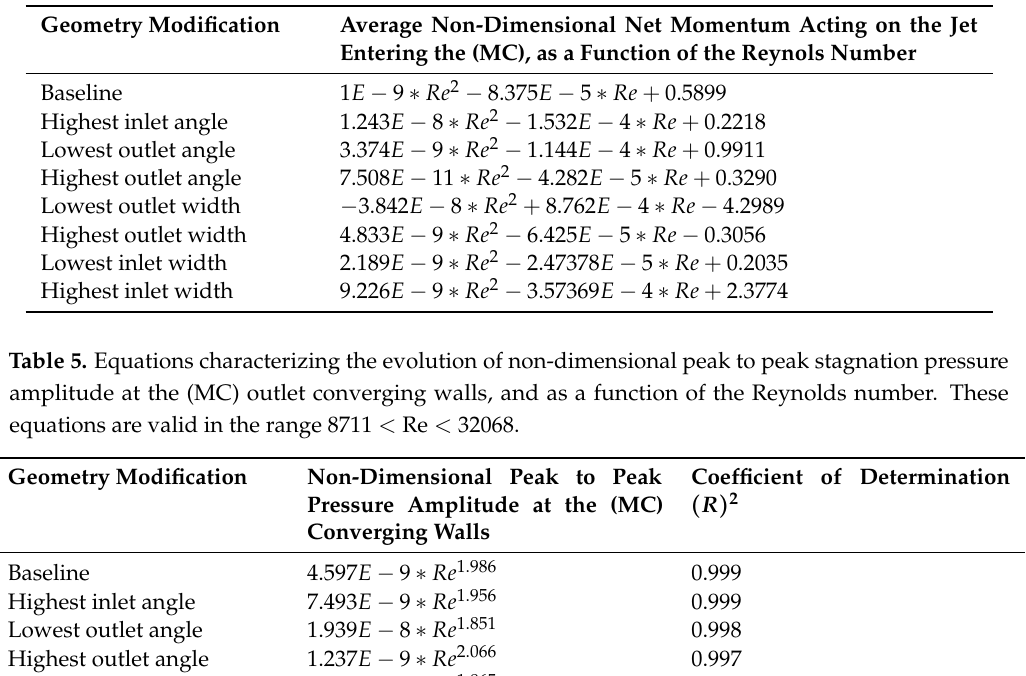
Table 4. Equations characterizing the evolution of non-dimensional average net momentum acting on the jet entering the (MC), and as a function of the Reynolds number. These equations are valid in the range 8711 < Re < 32068. The coefficient of determination was ( R ) 2 = 1 for all curves presented.